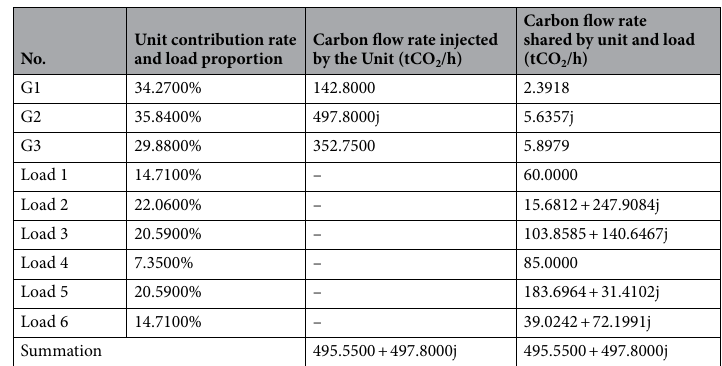
Table 3. Carbon emission flow rate for generator and load.